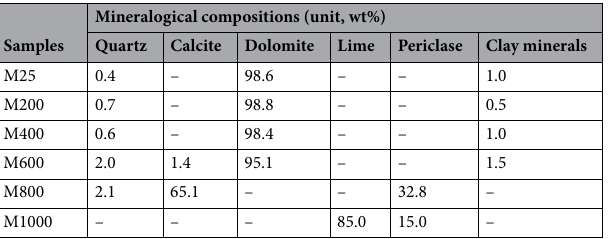
Table 1. Mineralogical compositions of marble samples exposed to different temperatures. Normally decimal part of XRD data only has qualitative meaning, decimal part in this table is self-generated by software.